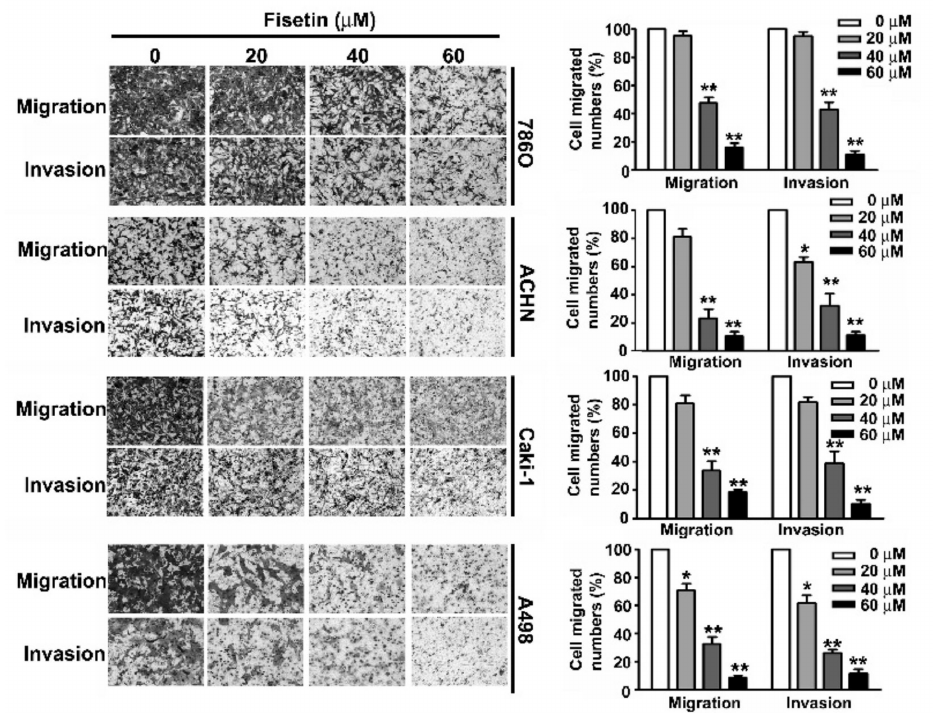
Figure 3. Fisetin inhibits cell migration and invasion of RCC cell lines. RCC cells were incubated with various concentrations (0, 20, 40, and 60 µ M) of fisetin. The migration and invasion abilities were determined using a migration assay and Matrigel invasion assay. The cells in the lower surface of the Borden chamber were stained and photographed under a light microscope at 400 × magnification. The quantification of migration and invasion abilities are shown as a histogram chart. Data are presented as the mean ± SE of at least three independent experiments. * p < 0.05, ** p < 0.01 compared with the untreated control (0 µ